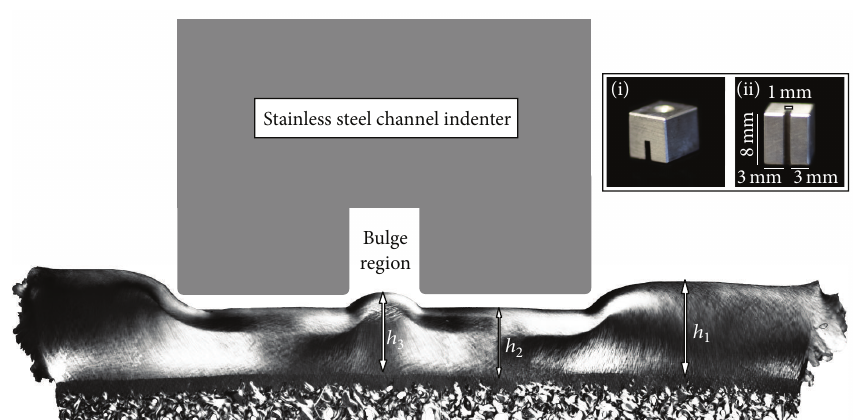
Figure 2: An illustration showing the channel indenter (shown in gray) profile in the compressed cartilage tissue. Note the tissue bulge in the channel space ( bulge region ). Microimages from each sample were used to measure ℎ 1 : the unloaded thickness, ℎ 2 : the directly loaded thickness, and ℎ 3 : the bulge height, in order to calculate the normal axial strain and bulge strain. Inset: photo of the steel channel indenter and its dimensions, with the indenter (i) upright and (ii) showing the